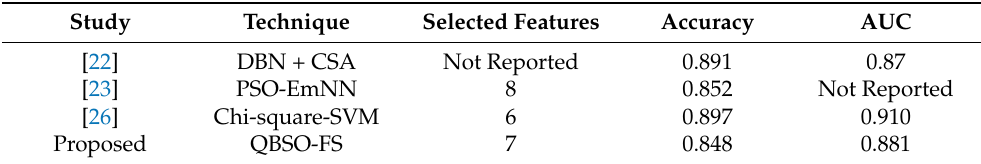
Table 10. Proposed model comparative analysis with the current state-of-the-art methods using the Statlog dataset.